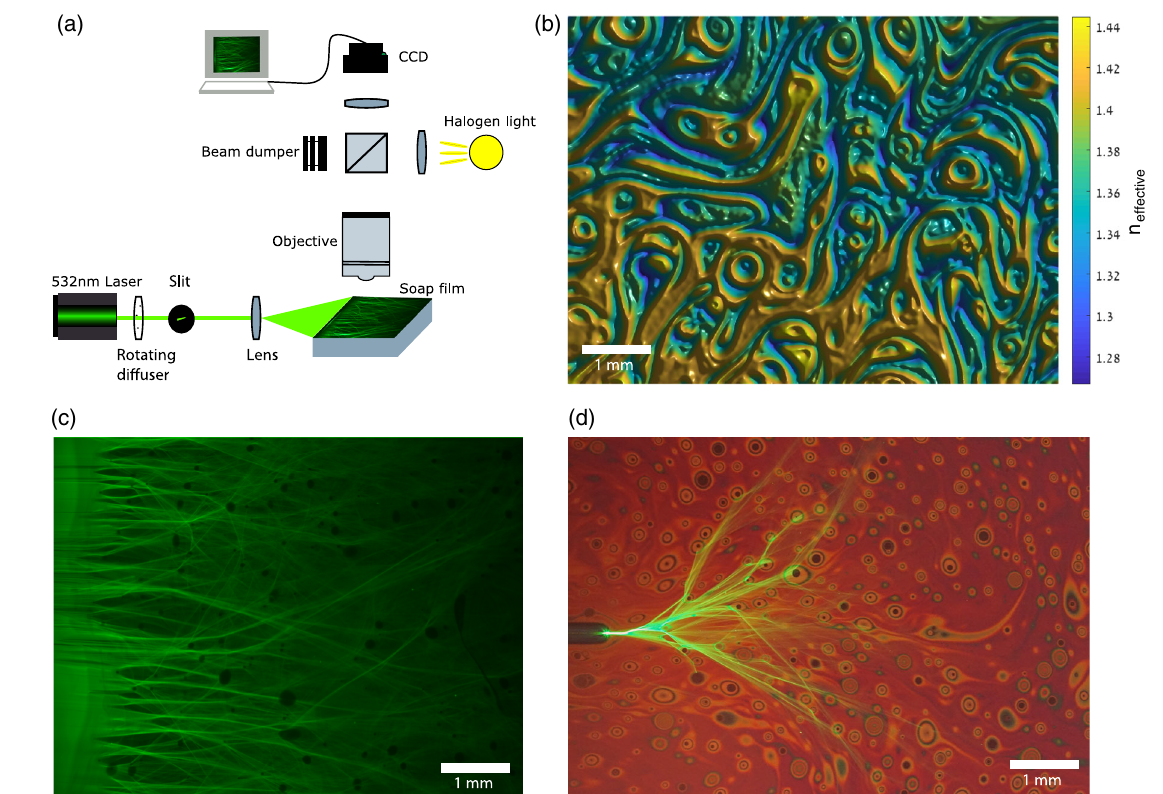
FIG. 1. (a) Experimental setup showing the main components, the path the light beam follows, and the imaging system. (b) Effective refractive index landscape of a soap film reconstructed using DNN from an image of the halogen light reflected from the film. (c) BF generated by a coherent plane wave. (d) BF generated by a localized source coupled to the film (the fiber tip seen on the